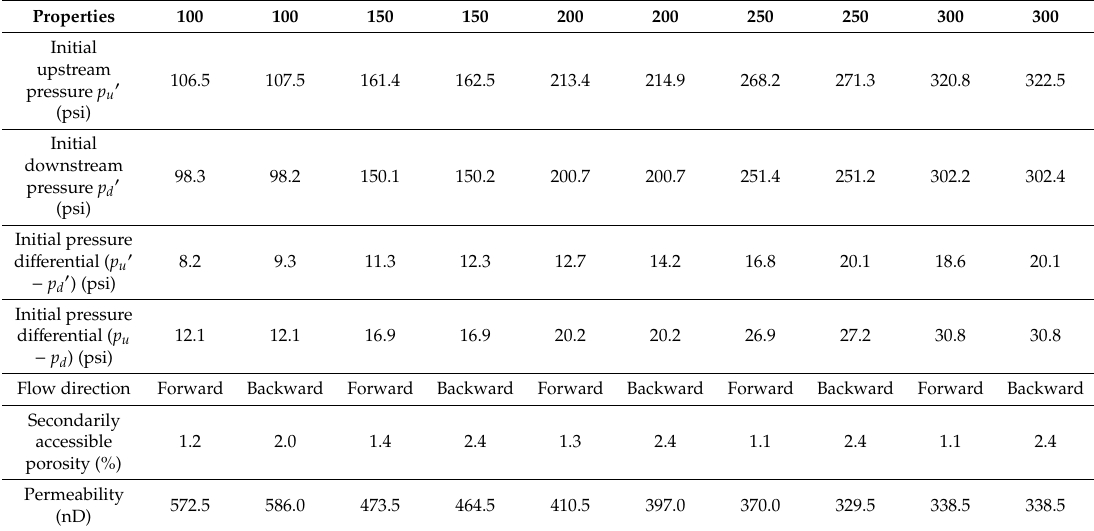
Table 3. Experimental details of each test ranging approximately from 100 psi to 300 psi.